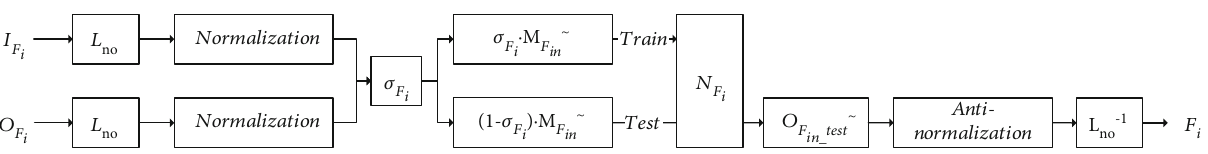
Figure 8: Training process of the orbit control network N